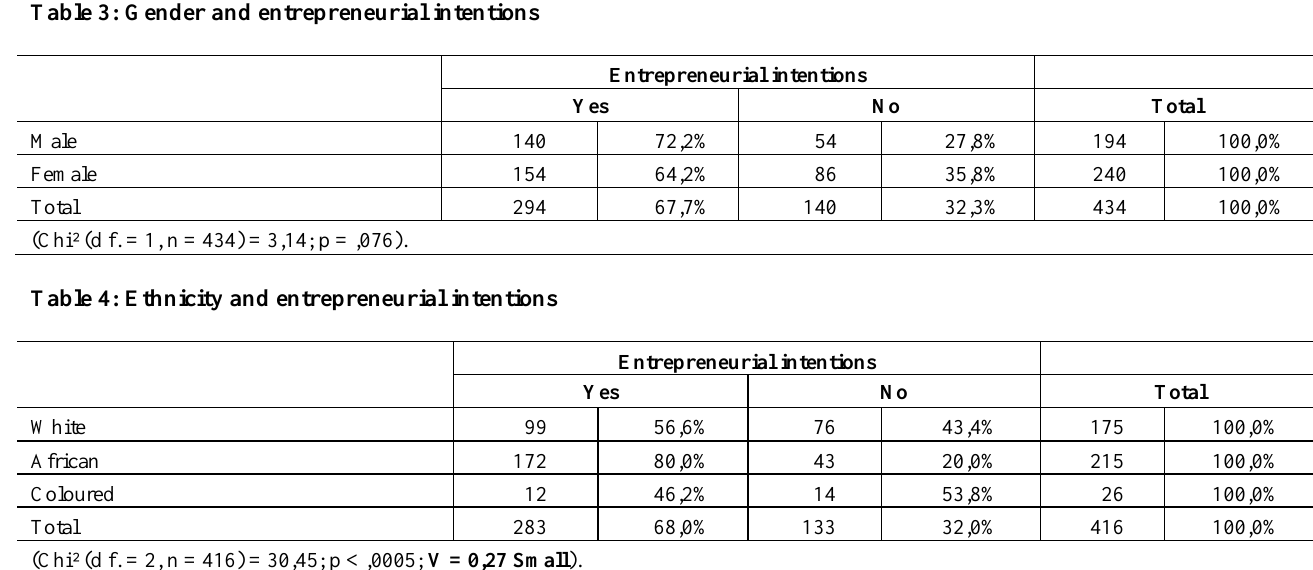
Table 3: Gender and entrepreneurial intentions